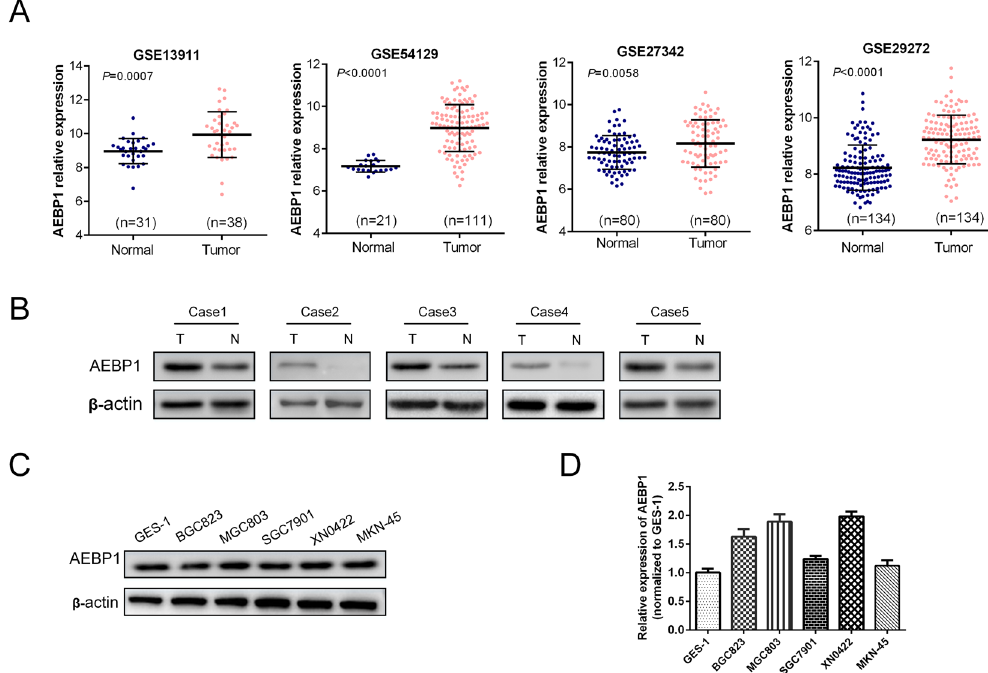
Figure 2. Expression of AEBP1 is elevated in gastric cancer tissues and cell lines. ( A ) Analyses of the AEBP1 mRNA levels from the NCBI GEO datasets GSE13911, GSE54129, GSE27342 and GSE29272. ( B ) Western blotting analysis of AEBP1 expression in 5 fresh surgical gastric cancer specimens (T) and corresponding adjacent normal tissues (N). ( C and D ) Western blotting and qRT-PCR analyses of AEBP1 in four gastric cancer cell lines (MKN-45, BGC823, MGC803, SGC7901) and a primary gastric cancer cell XN0422 as well as in GES-1. The western blots were derived under the same experimental conditions from the same cell lysates; the original full-length Western blot images are shown in Supplementary Fig.